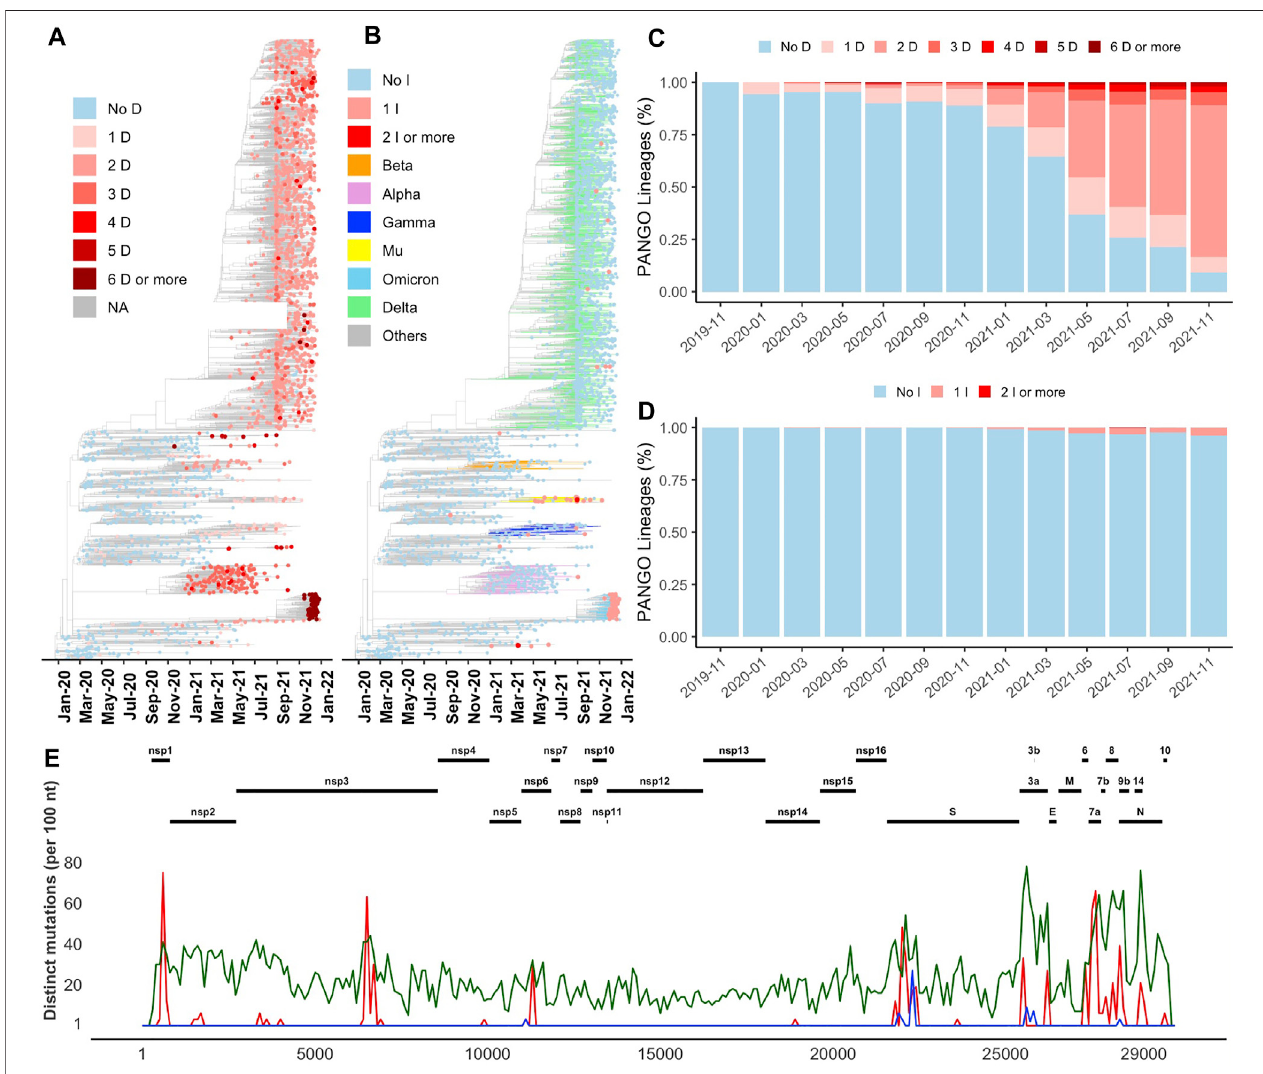
FIGURE 1 | Distribution of indels in SARS-CoV-2 genomes (A) and (B) Increase in the number of deletion (D) and insertion (I) events in newly emerged lineages illustrated on Nextstrain ’ s time-resolved phylogenetic tree, respectively (C) and (D) Percentage of PANGO lineages with and without deletion and insertion events over time,respectively (E) Distributionofthe mostcommon deletions alongtheSARS-CoV-2genome (red) compared toinsertions (blue)and missensesubstitutions (green).